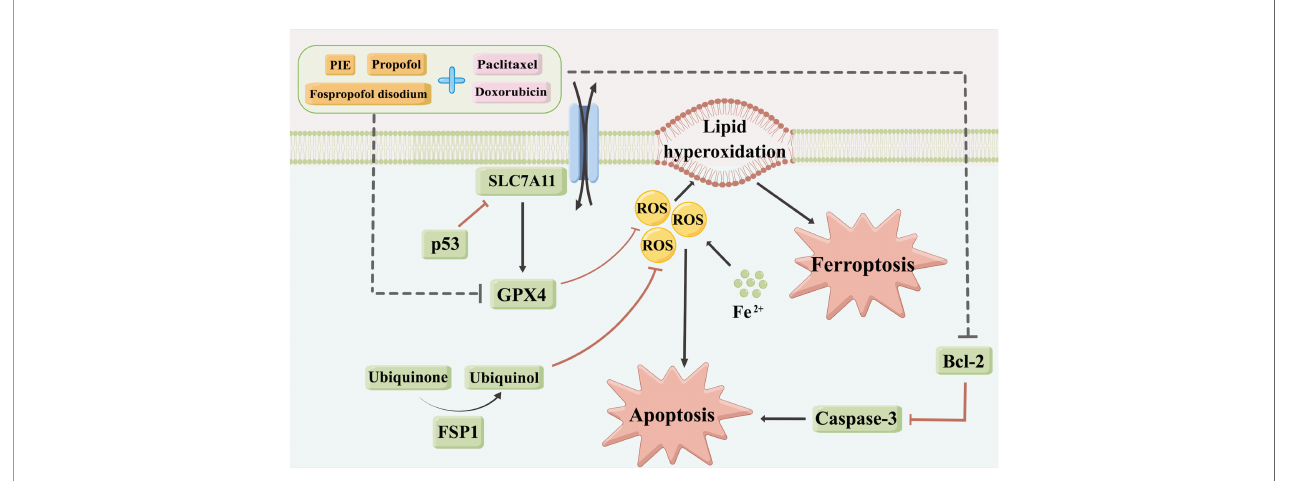
FIGURE 7 | A schematic diagram of potential mechanisms for drug treatment caused apoptosis and ferroptosis in this study (By Figdraw, www. fi